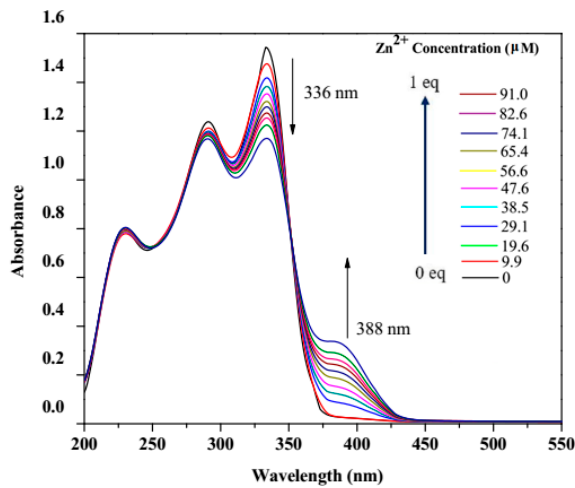
Figure 7. UV-vis titration of an ethanolic solution of hpbtz (1 × 10 − 4 M) with Zn 2+ ion (1 × 10 − 3 M).